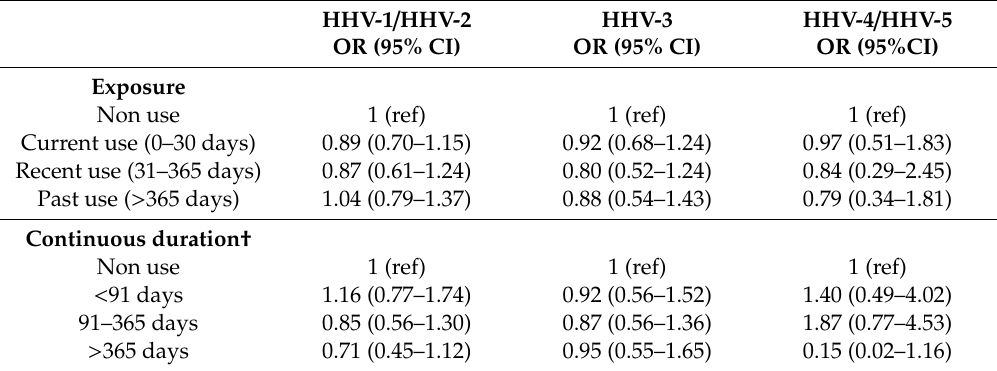
Table 6. Use of valproic acid and risk of clinical infections by di ff erent